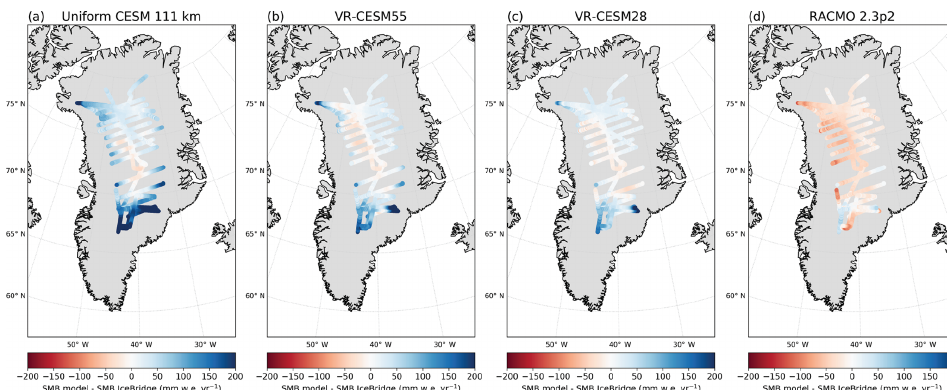
Figure 5. SMB differences between IceBridge radar (mean over available period) and model climatology (1980–1999). Blue (red) colours indicate that the model is wetter (dryer) than